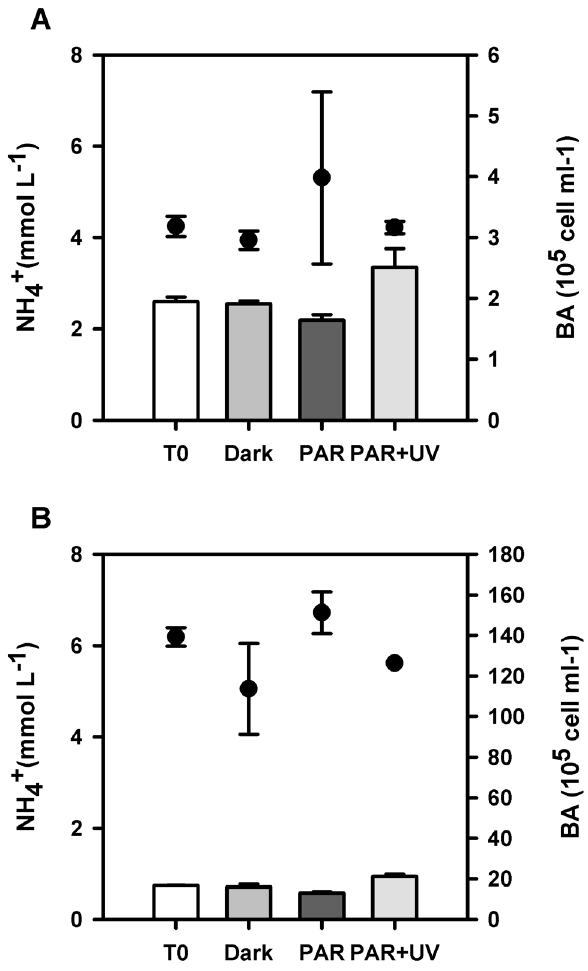
Figure 7. Evolution of ammonium concentrations during experiments of dissolved organic matter photodegradation (PAR + UVR vs PAR vs Dark) using marine DOM. Experiments carried out during A) September 2011 and B) January 2012. Vertical bars represent ammonium concentration per treatment. Bacterioplankton abundances (BA) are represented by circles. All samples were taken in duplicate.